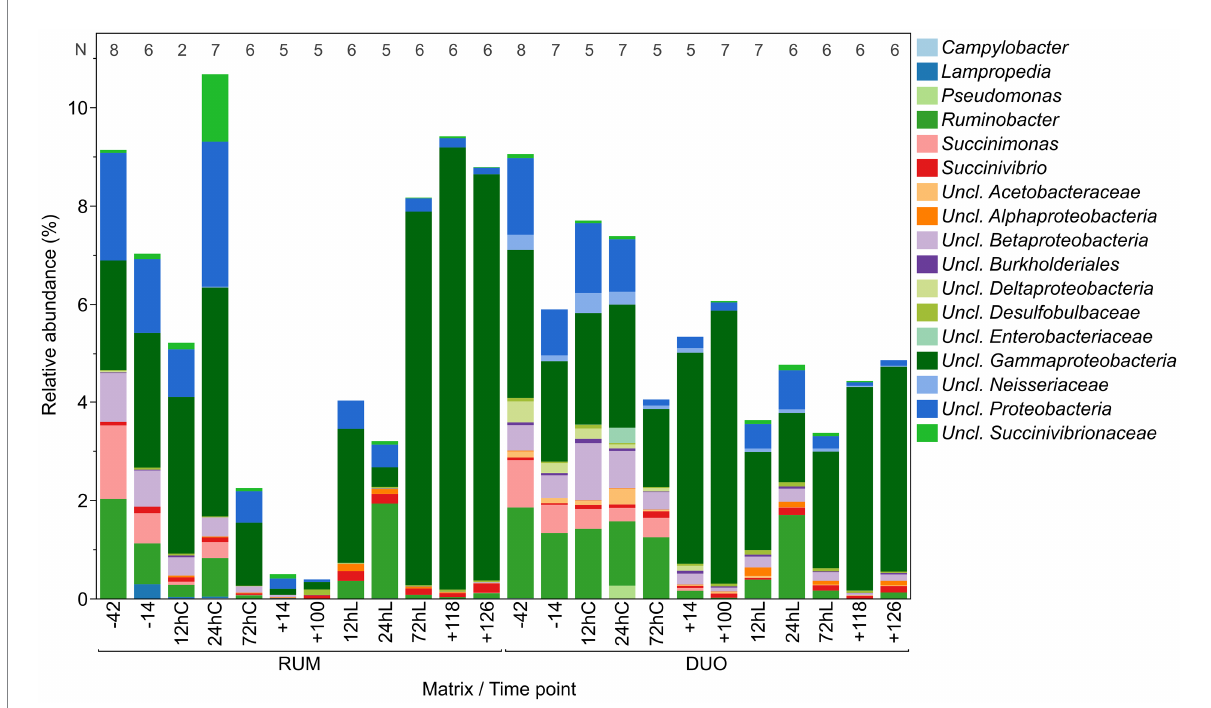
FIGURE 5 Relative abundance of Proteobacteria genera in rumen (RUM) and duodenal fluid (DUO). N -Values refer to sample number included per time point. Time points including a “–” or “+” indicate days antepartum or postpartum and time points including “hC” or “hL” are samples taken at 12, 24, or 72 h after calving or LPS challenge,